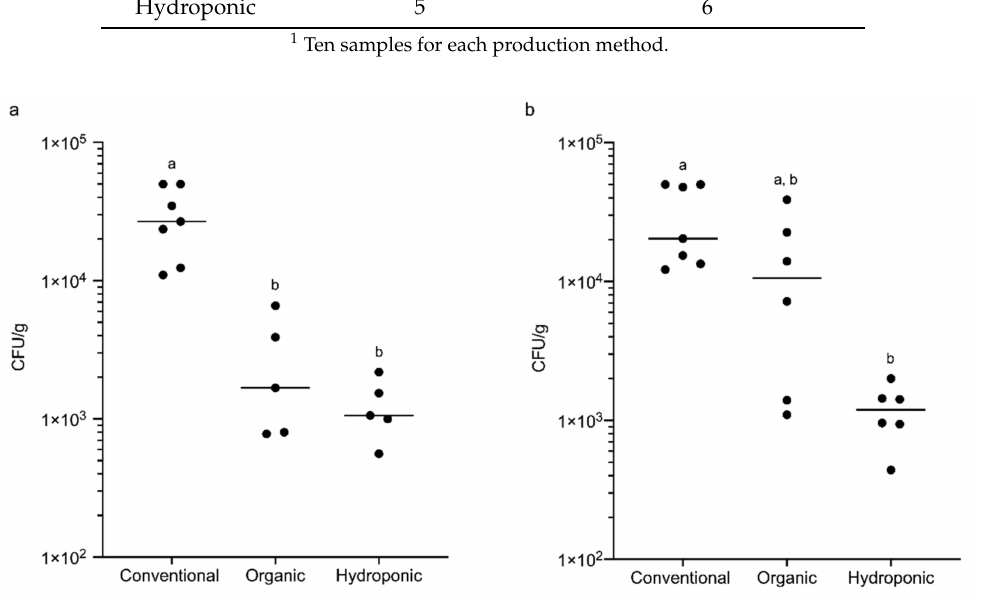
Figure 1. The number of antibiotic-resistant bacteria isolated from lettuce of three di ff erent production methods: ( a ) tetracycline-resistant bacteria; ( b ) sulphadiazine-resistant bacteria (ten samples for each production method). Di ff erent letters indicate a significant di ff erence ( p < 0.05), one-way ANOVA with a Kruskal–Wallis comparison